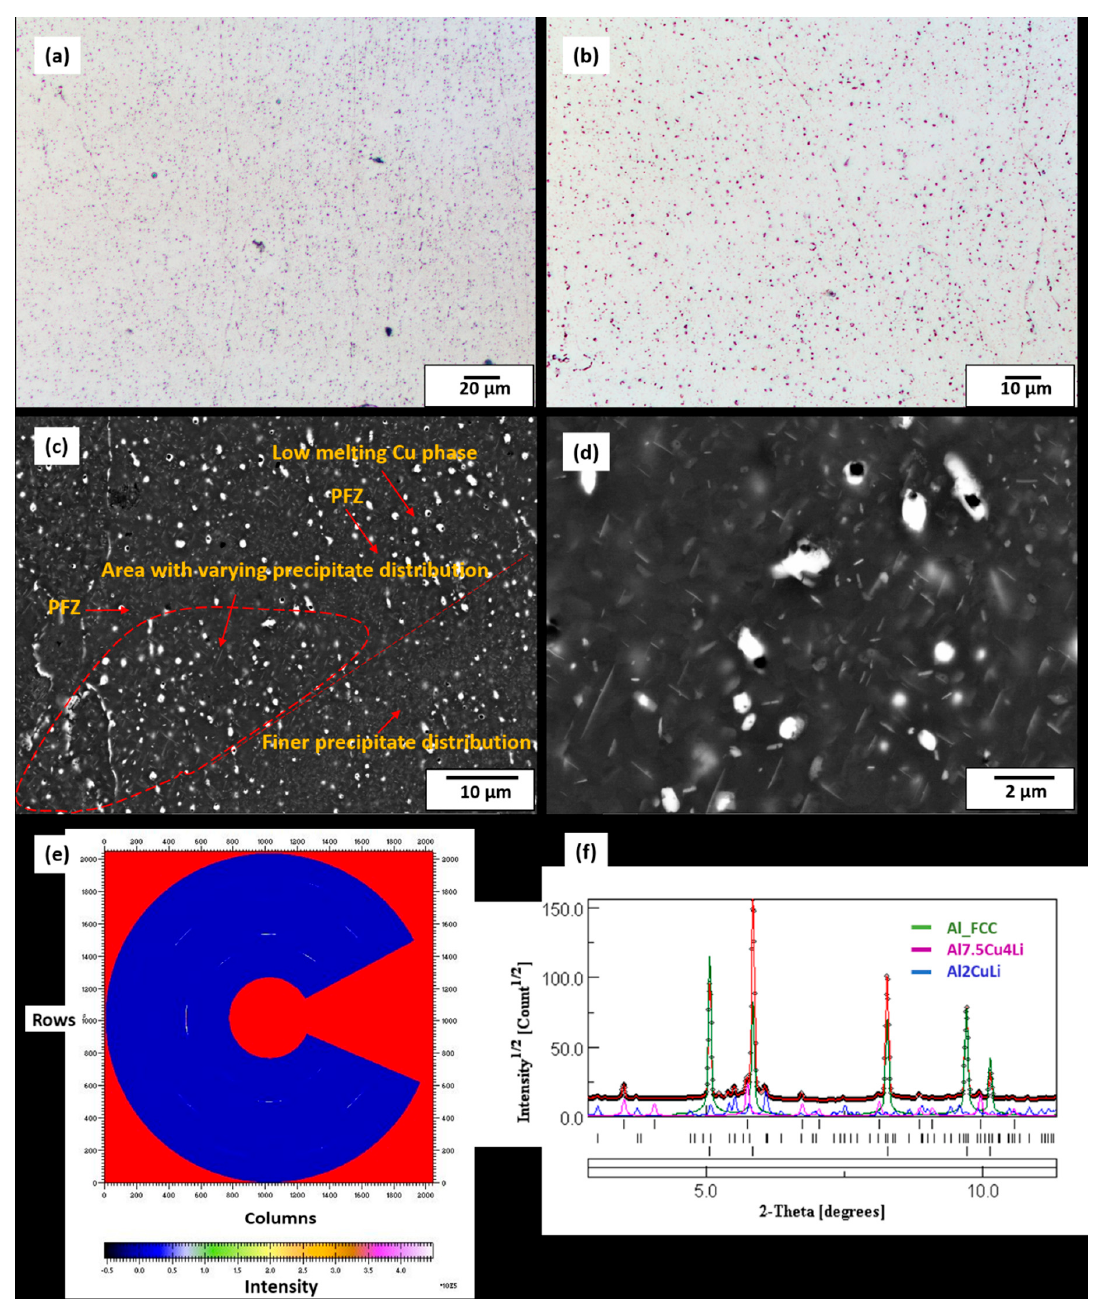
Figure 6. ( a , b ) LOM micrographs of etched preheat-treated sample (320 °C). ( c , d ) SEM micrographs of preheat-treated sample (320° C) showing rod-like precipitates suspected to be T 1 and T B plates of varying sizes as well as globular precipitates which appear to be rich in Cu. Synchrotron High-Energy X-ray Diffraction (S-HEXRD) measurements (320 °C sample), ( e ) masked ring pattern, ( f ) diffraction peaks confirming two main dominant phases, T 1 and T B .